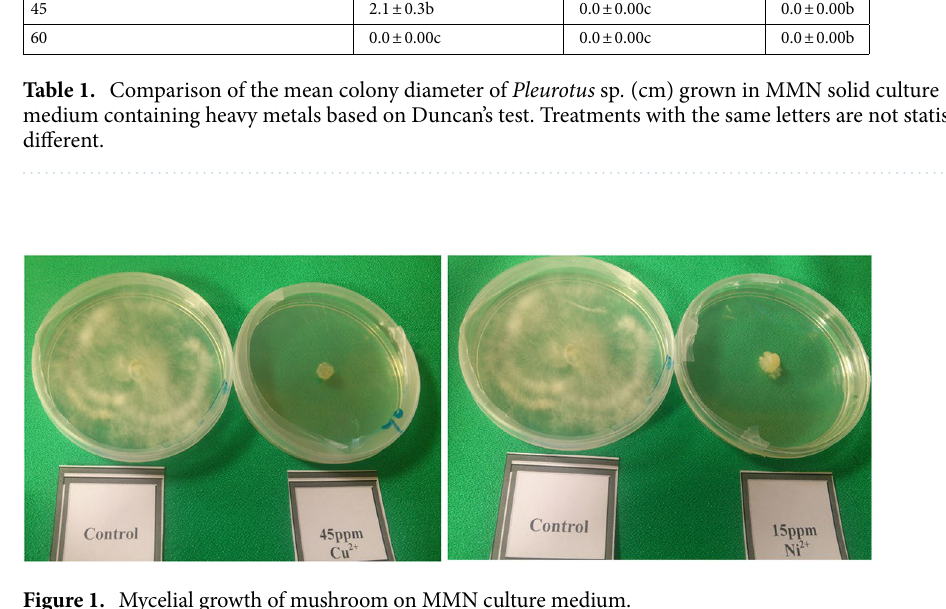
Figure 1. Mycelial growth of mushroom on MMN culture medium.